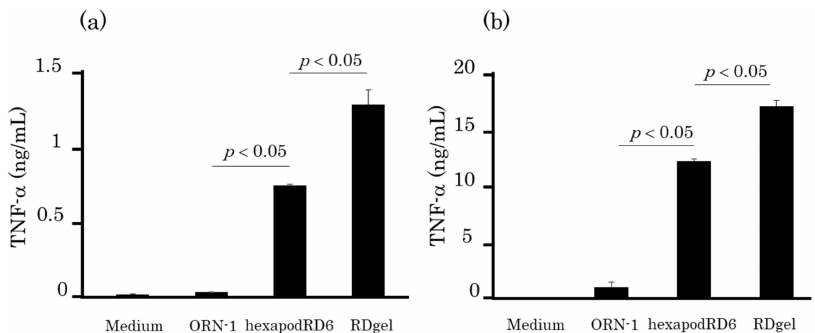
Figure 7. Tumor necrosis factor (TNF)- α release from immune cells after addition of ORN-1, hexapodRD6, and RDgel. TNF- α released from ( a ) DC2.4 cells or ( b ) RAW2.4 cells was measured at 20 h or 8 h, respectively, after RNA / DNA addition. The results are expressed as mean ± SD of three independent experiments.